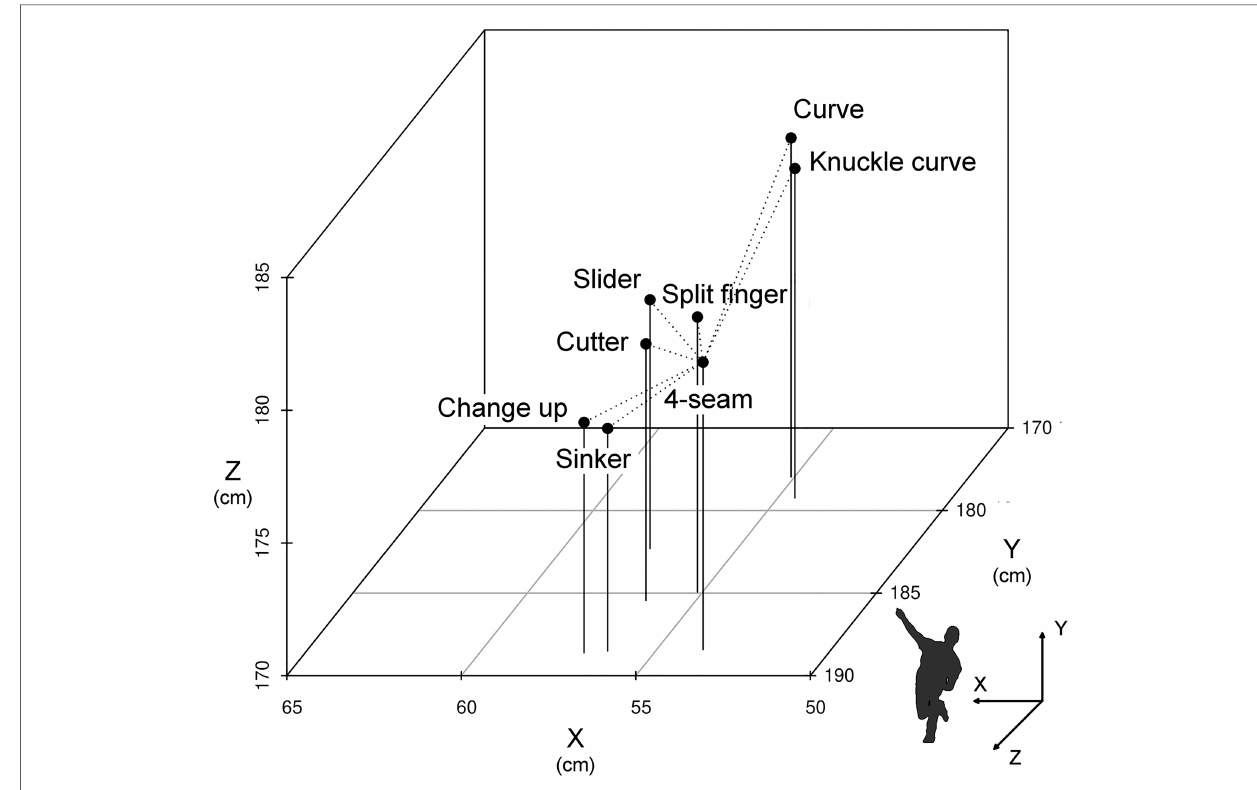
FIGURE 2 3D coordinates of the release point for each ball type. 4-seam mean was used as the reference point for corrected